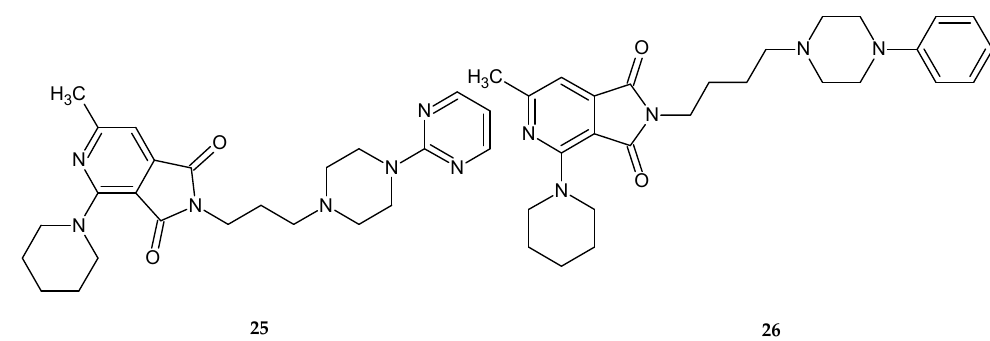
Figure 21. Derivatives of pyrrolo[3,4 ‐ c ]pyridines 25 and 26 with significantly sedative activity [27].